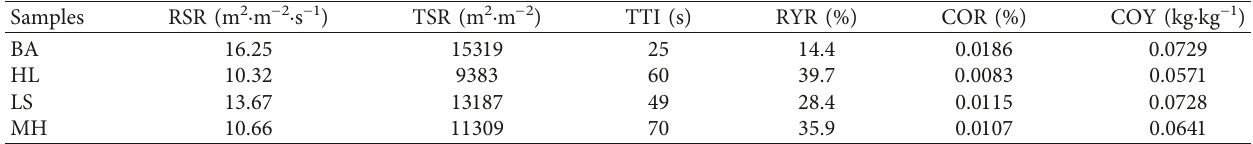
Table 2: Smoke release properties obtained from cone calorimeter.